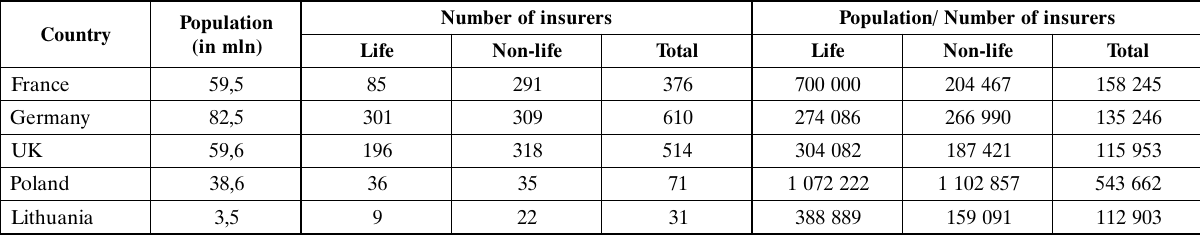
Table 11. Potential competition in a selected country, 2001